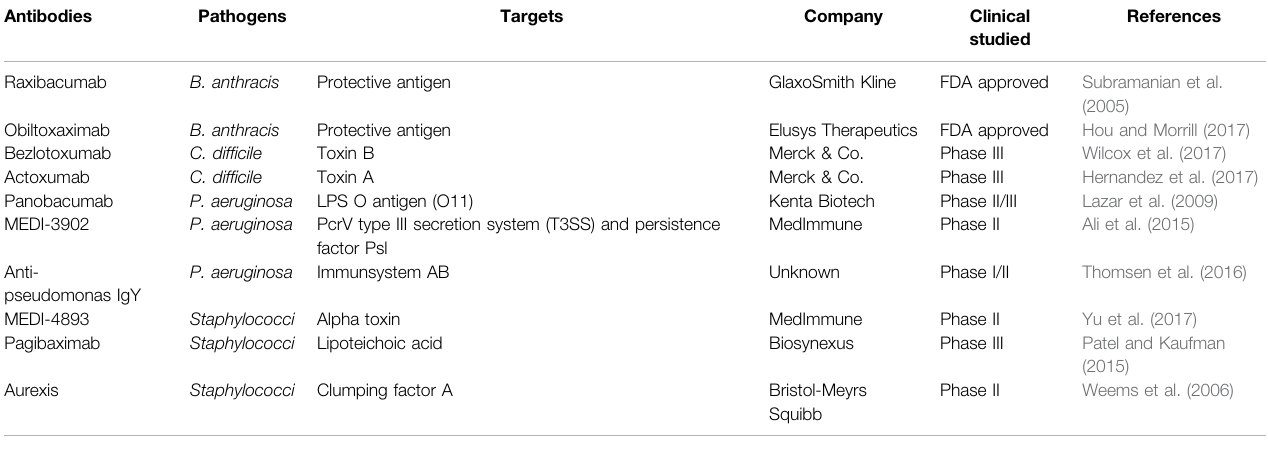
TABLE 2 | Typical antibodies against four pathogenic bacteria in drug development. Antibodies